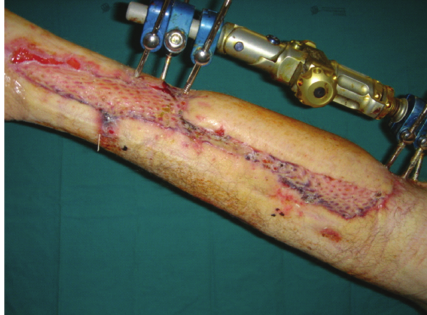
Figure 4: Results at 6 months of